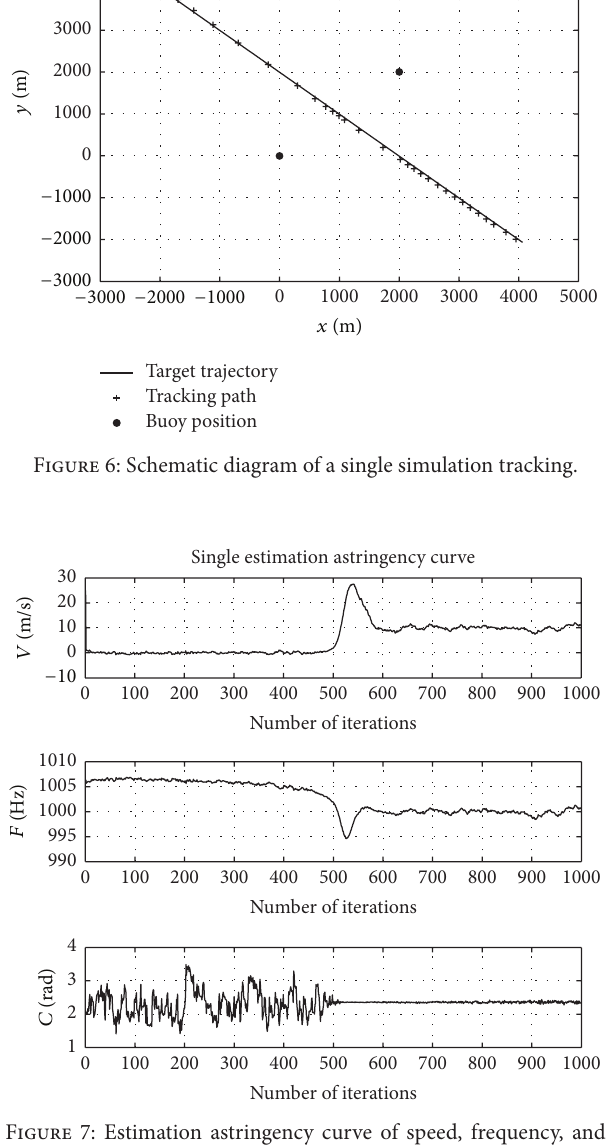
Figure 7: Estimation astringency curve of speed, frequency, and course.